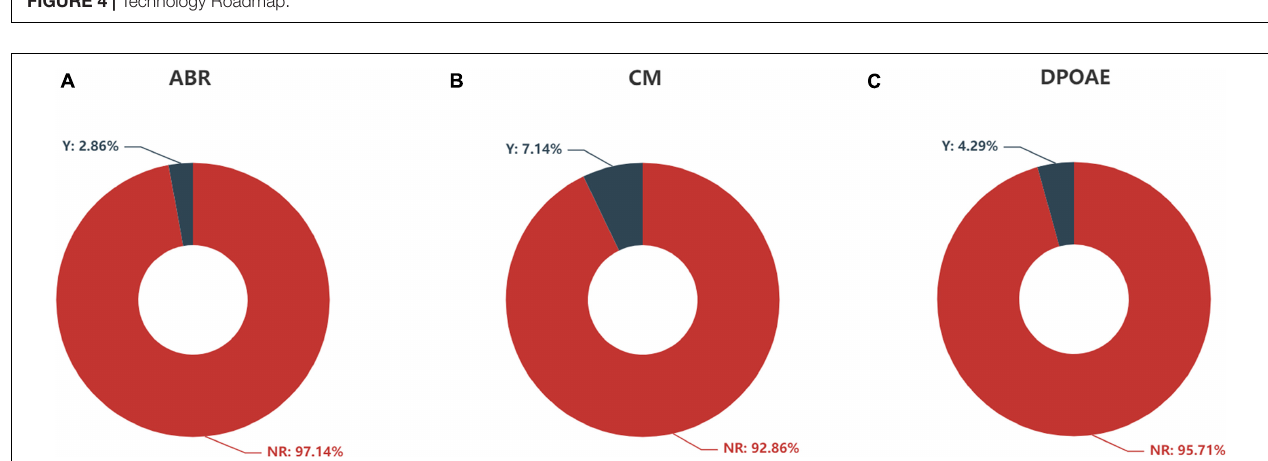
Frontiers in Neuroscience |